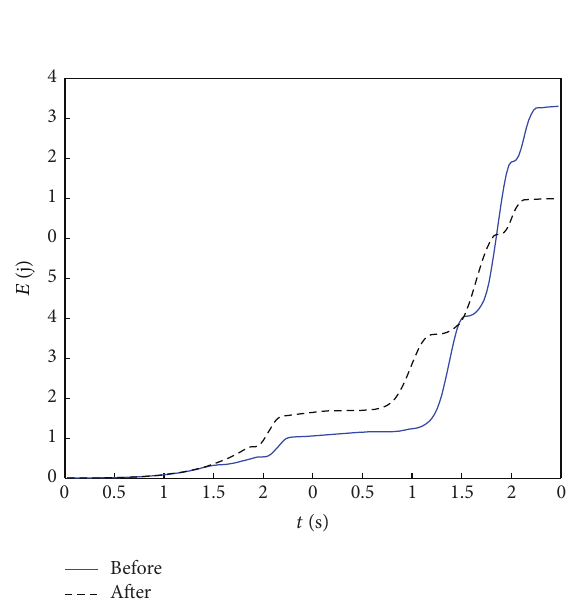
Figure 9: System energy consumption of galloping.